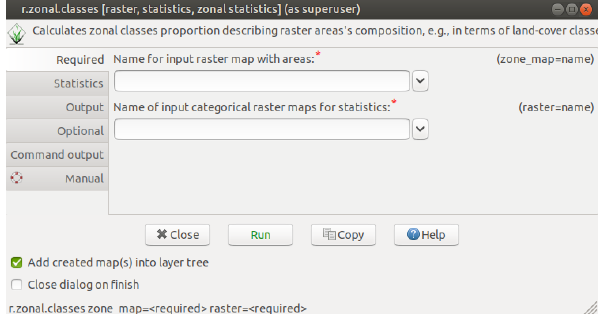
Figure 2 . Part of the processing step has already been implemented in a user friendly click-button tool called